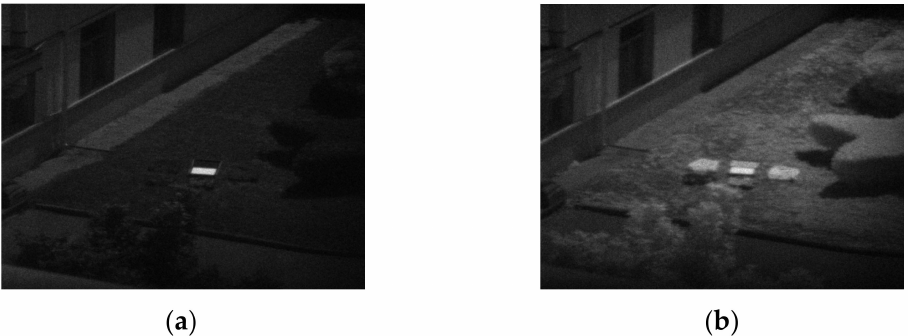
Figure 3. Single band grayscale images at different wavelengths. ( a ) Single band grayscale images at 553 nm. ( b ) Single band grayscale images at 801